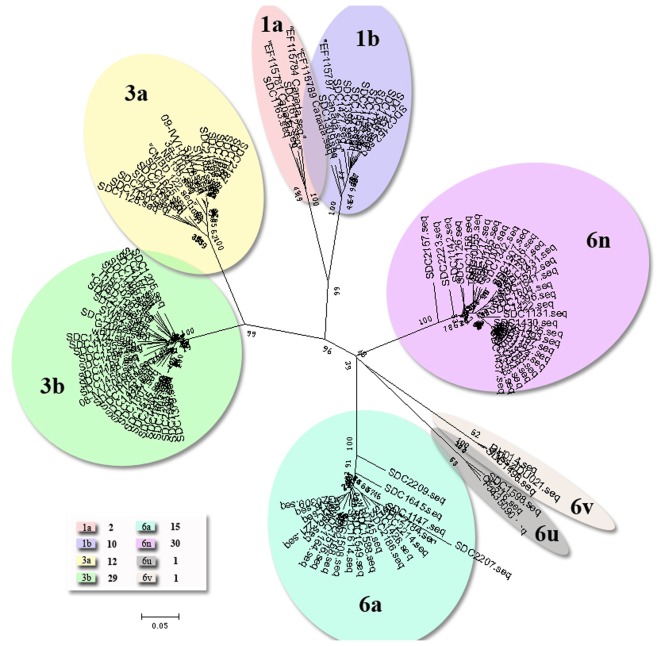
A phylogenetic tree estimated from C/E1 fragment sequences corresponding to H77 (nucleotide positions, 843–1315).